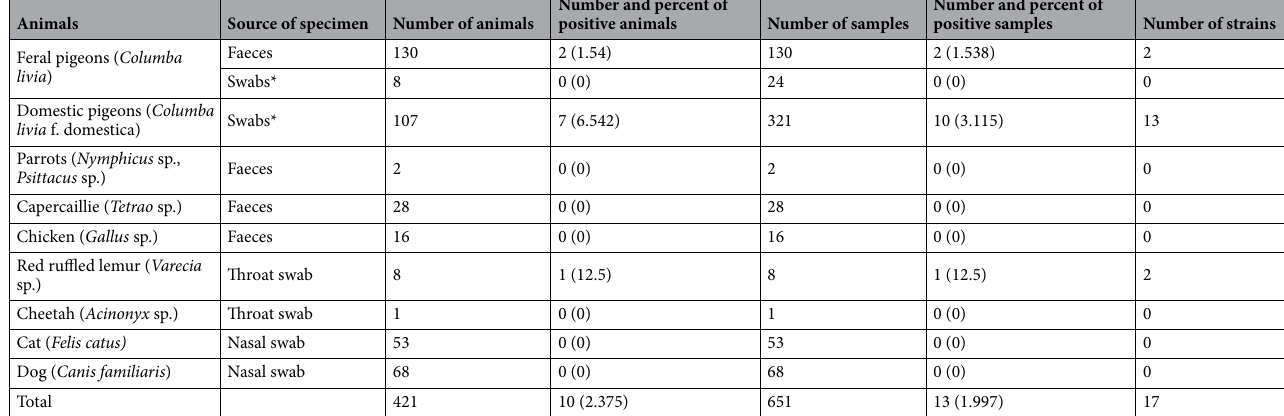
Table 1. The results of isolation of CNGSC strains from animal originating specimens. *Sets of swabs from oropharynx, crop and cloaca taken from every examined